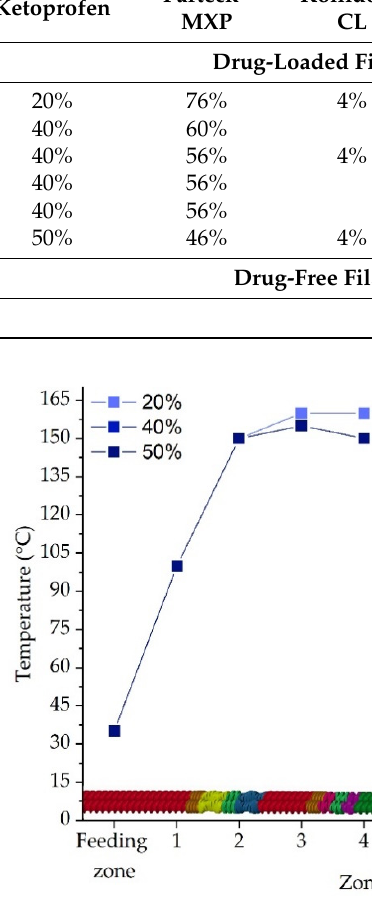
Figure 15. Screw design and temperature profile for formulations with different ketoprofen concentrations.